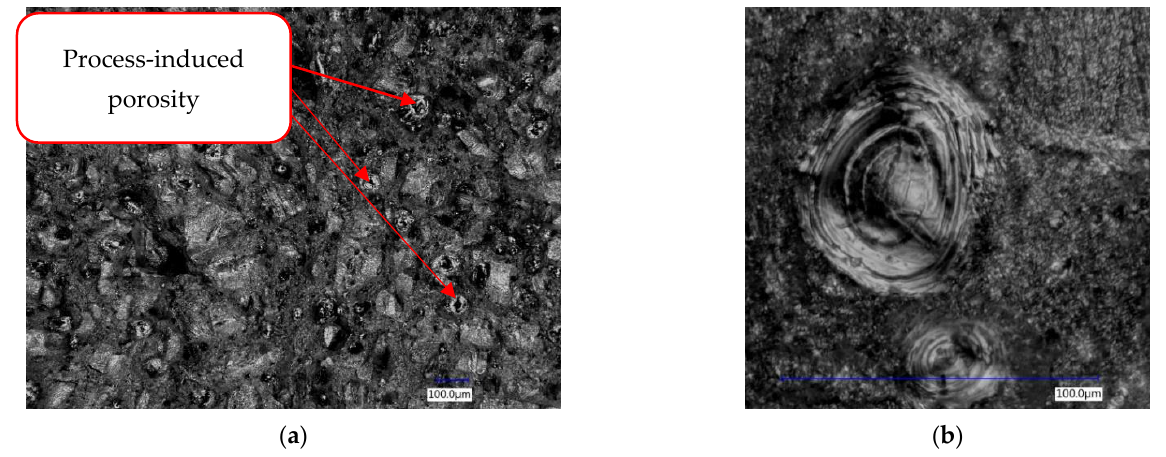
Figure 13. Fracture analysis with the Keyence VHX-6000 Digital Microscope ( a ) Fracture surface; ( b ) Discovered pores on the surface, close-up